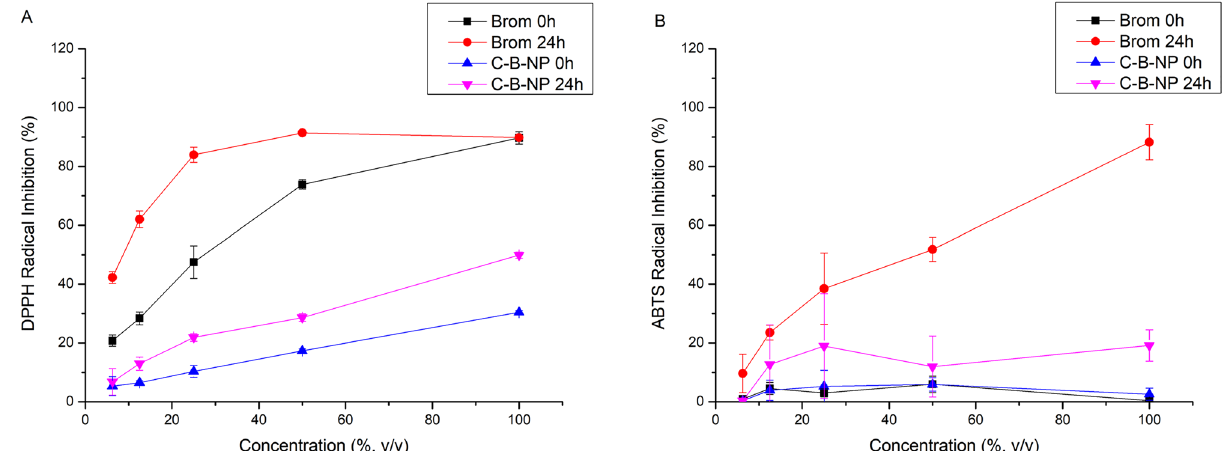
Figure 2. Antioxidant activity using ( A ) 2,2-diphenyl-1-picrylhydrazyl (DPPH) and ( B ) 2,2-azino-bis-3- ethylbenzothiazoline-6 sulfonic acid (ABTS) radicals. Brom bromelain solution, Chi-Brom NP chitosan-